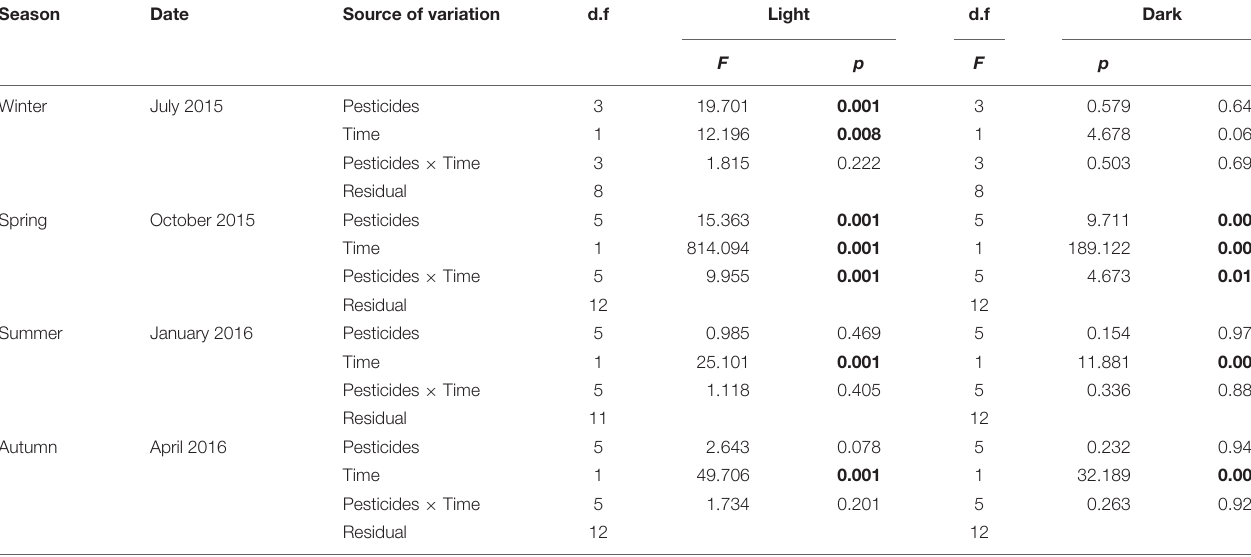
FIGURE 7 | Photoautotrophic and chemoautotrophic ammonium uptake rates ( µ mol L − 1 h − 1 ) during on-deck experiments under light and dark conditions. (A,E) Winter 2015; (B,F) Spring 2015; (C,G) Summer 2016; (D,H) Autumn 2016. TABLE 4 | Results from two-way ANOVA examining the effect of pesticides and the incubation time on N uptake rates obtained during on-deck experiments under light and dark conditions at Llico Bay. Season Source of variation d.f Light d.f